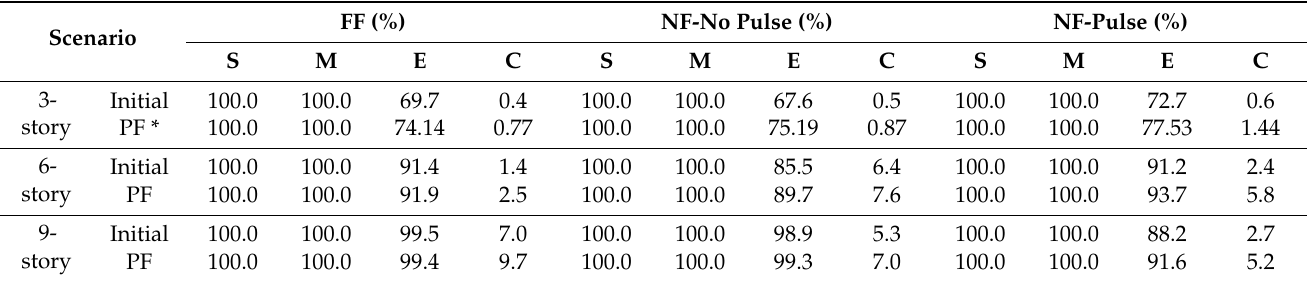
Table 5. Comparison of exceedance probability in pre- and post-fire seismic